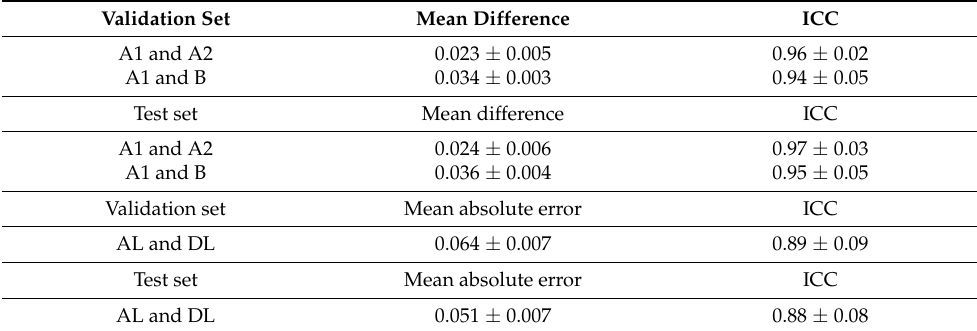
Table 3. Mean difference, mean absolute error, and ICC in the validation and test sets.